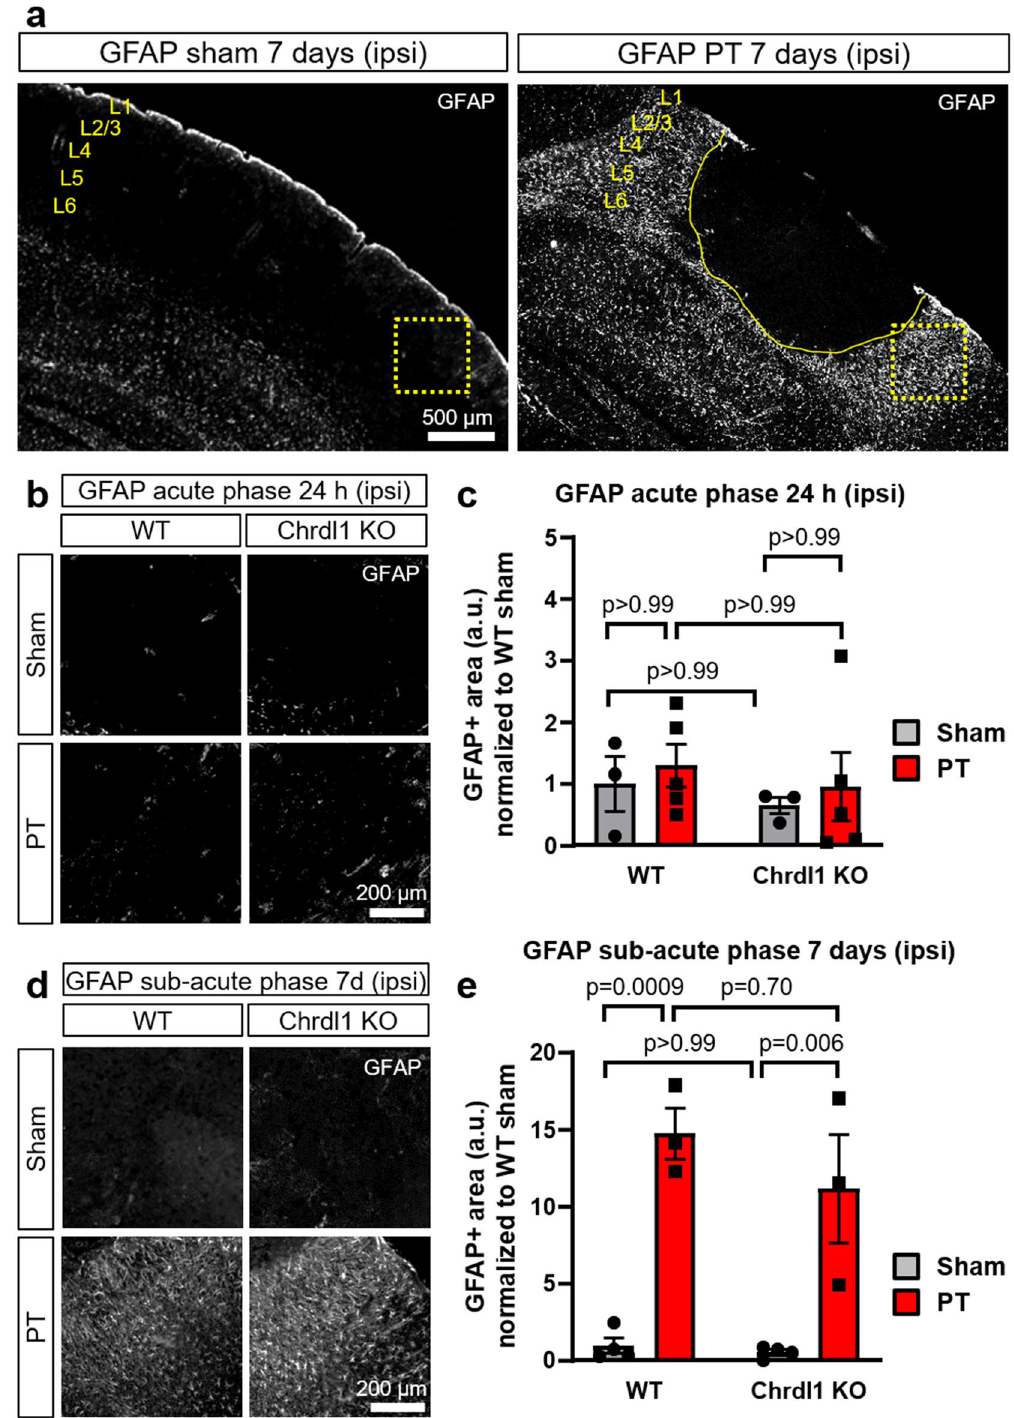
Figure 3. Reactive astrogliosis is not impaired in Chrdl1 KO mice after PT injury. ( a ) Representative images of the upper layers of the visual cortex of a WT mouse 7 days after sham surgery or PT for GFAP protein staining. The area in a dashed box is the region where analysis was performed. Core of the ischemic injury is delineated by the solid yellow line. Scale bar 500 µm. ( b ) Representative images of the peri-infarct area of WT and Chrdl1 KO mice 24 h after PT or sham surgery immunostained for GFAP. ( c ) Quantification of GFAP + stained area normalized to WT sham. WT sham N = 3, WT PT N = 5, Chrdl1 KO sham N = 3 and Chrdl1 KO PT N = 5 mice. ( d , e ) Same as ( a , b ) 7 days after PT or sham surgery immunostained for GFAP. WT sham N = 4, WT PT N = 3, Chrdl1 KO sham N = 4 and Chrdl1 KO PT N = 3 mice. Statistics by two-way ANOVA. Scale bar 200